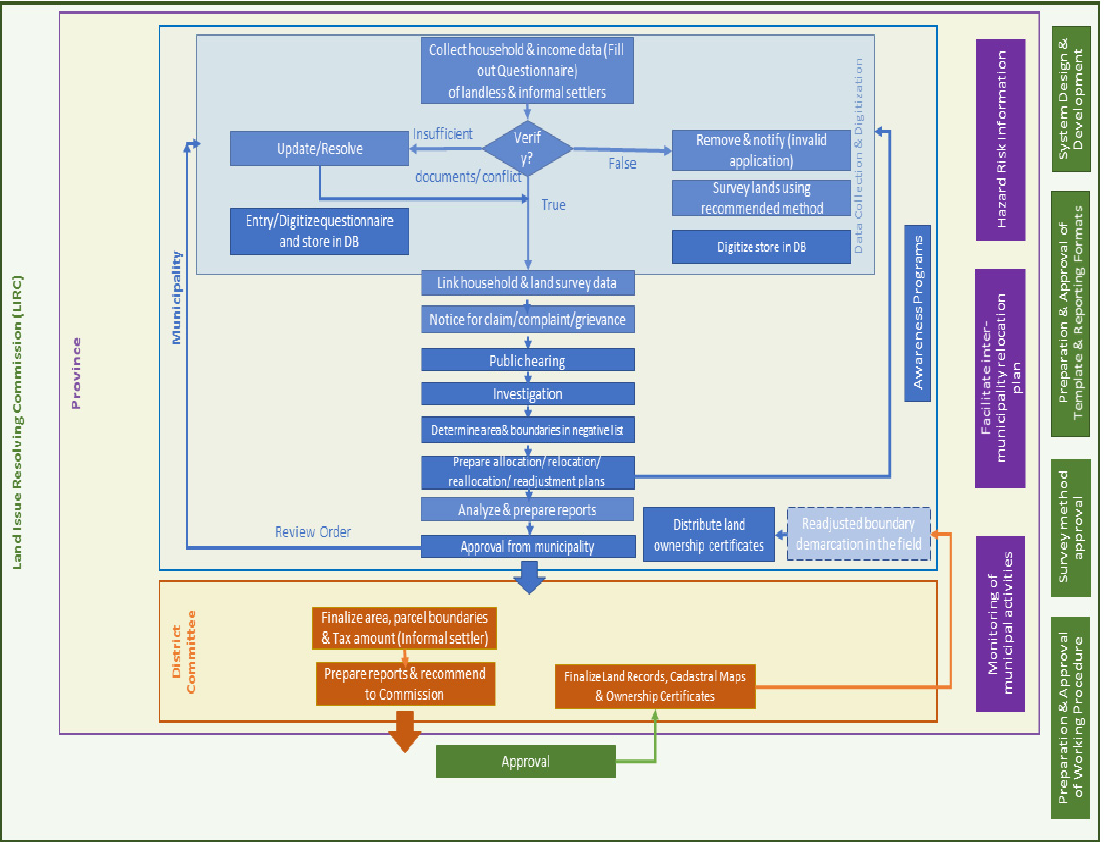
Figure 5. Process workflow depicting roles and responsibilities of different institutions (The box with dashed boundary is not mandatory).